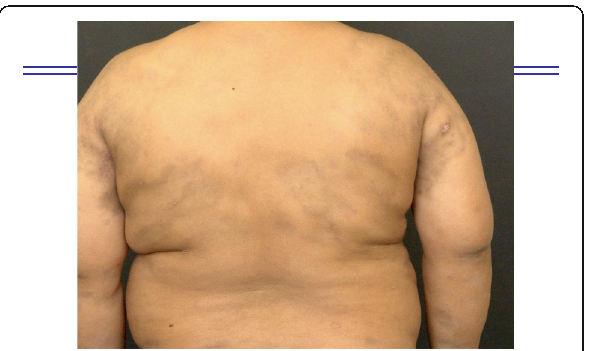
Fig. 1 Lupus erythematosus panniculitis showing extense areas of cutaneous atrophy affecting the back and limbs.